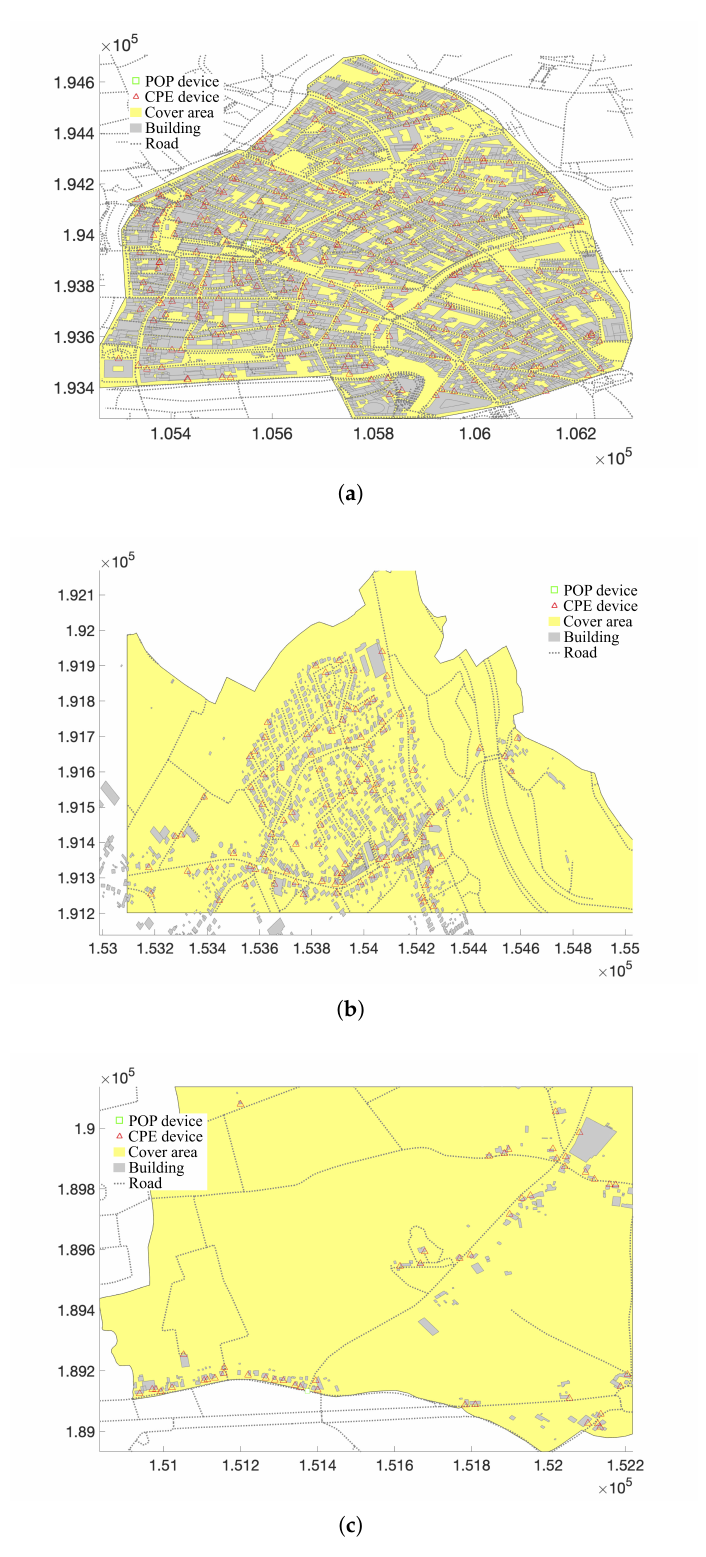
Figure 2. Simulation environments for FWA network characterization, with gray surfaces repre- senting the buildings, dashed lines representing the roads, red triangles representing simulated customer premises equipment ( CPE ) locations, a green square representing the fiber point of presence (POP), and the considered surface area shown in yellow. ( a ) Urban city (Ghent). ( b ) Village (Leest). ( c ) Rural